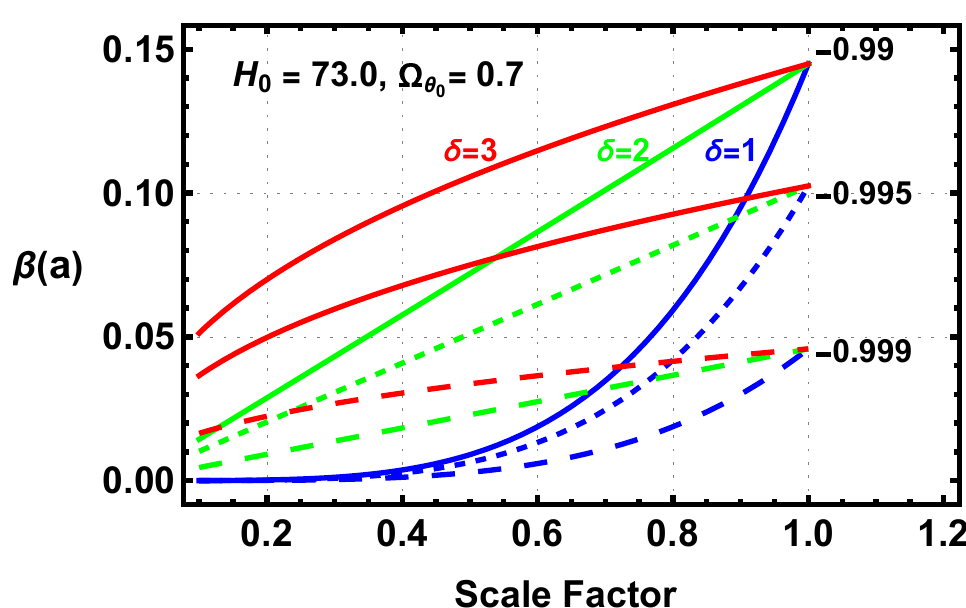
Figure 5. The figure shows the evolution of the beta function for all cases in this study. Although the general nature of the evolution of the beta function is different from the scalar, it shows the same change in the second derivative of the evolution, positive for δ = 1, almost zero for δ = 2, and negative for δ = 3. The absolute value of β is small and decreases as w 0 approaches − 1. The current value of beta, β 0 , is identical for a given (cid:113) ( w + 1 ) , where the subscript 0 value of w 0 due to Equation (14), which sets β 0 at 3 Ω θ 0 0 indicates the current values. The beta function appears in many cosmological parameters due to Equation (13) that links κ ˙ θ and the Hubble